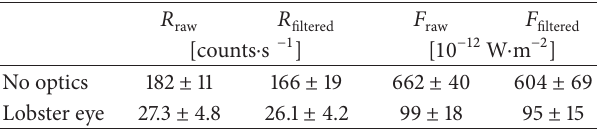
Table 2: Count-rates 𝑅 and fluxes 𝐹 of Lobster eye optics compared to clear data without optics at 4.5 keV Titanium X-ray emission. Raw measureddatabetween1and20secondsandmathematicallyfiltered data correspond to Figure